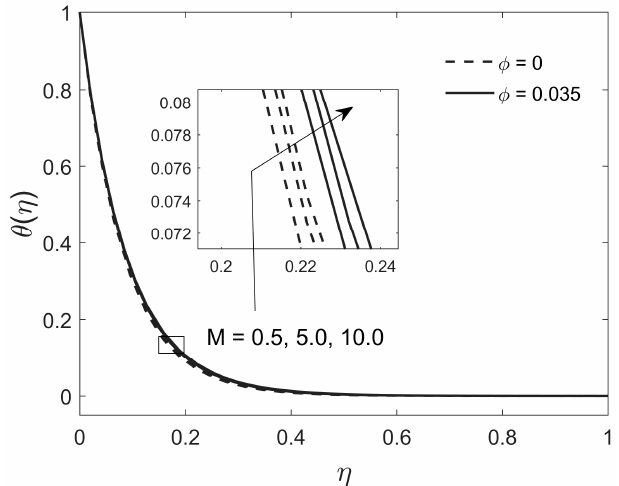
Figure 9. Effect of the magnetic field on the temperature distribution.